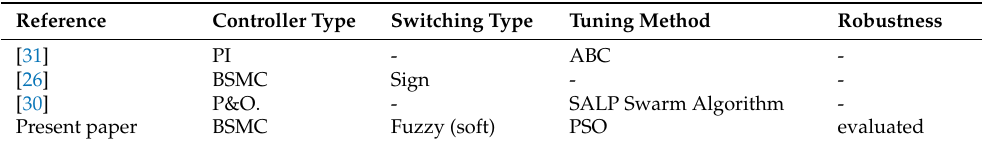
Table 1. Comparing the